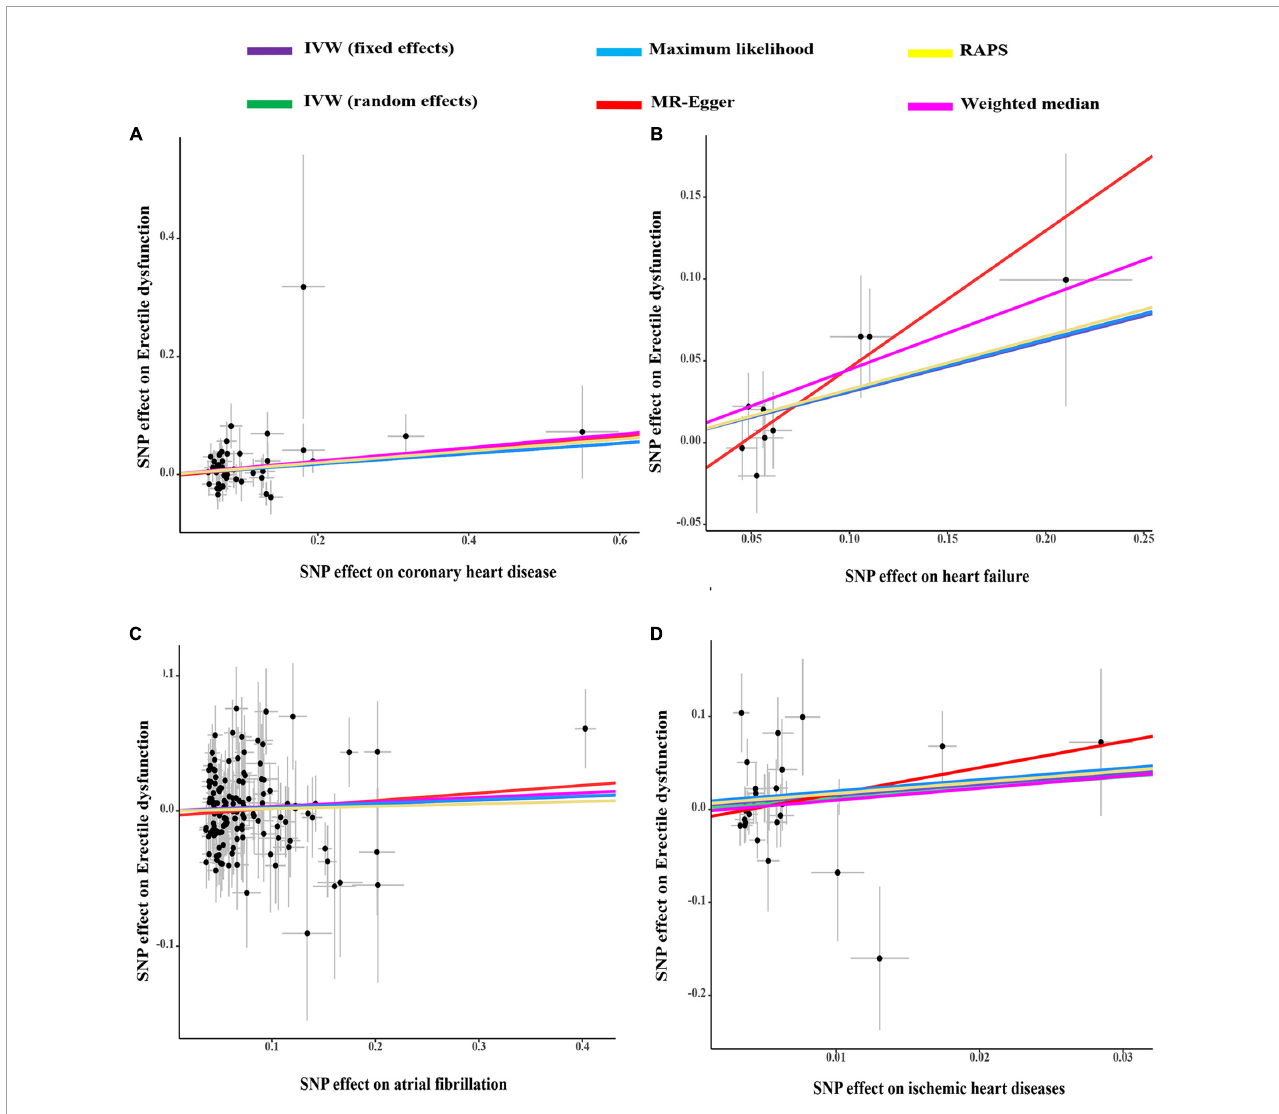
FIGURE2 The scatter plots of coronary heart disease (A) , heart failure (B) , atrial fibrillation (C) , and ischemic heart disease (D) on ED. IVW, inverse variance weighting; MR, Mendelian randomization; SNP, single nucleotide polymorphisms; ED, erectile